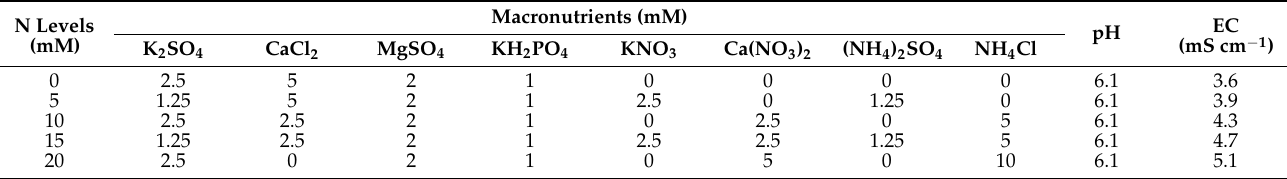
Table 1. Formula of